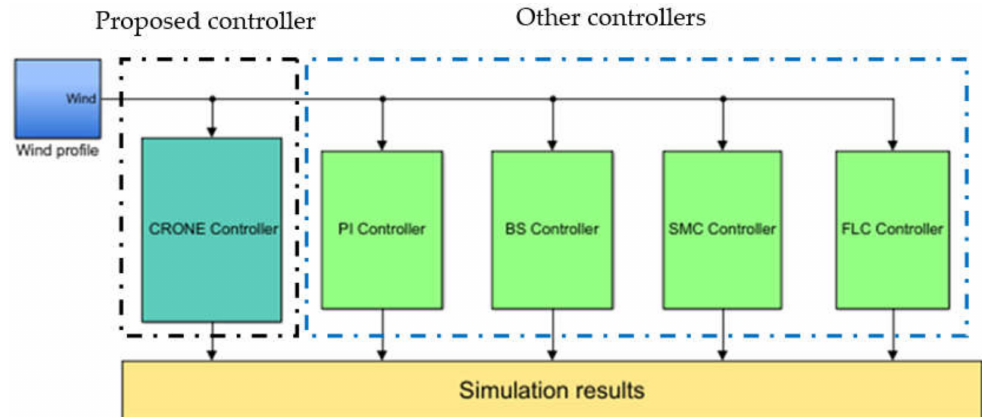
Figure 10. Matlab/Simulink architecture of the designed controllers.